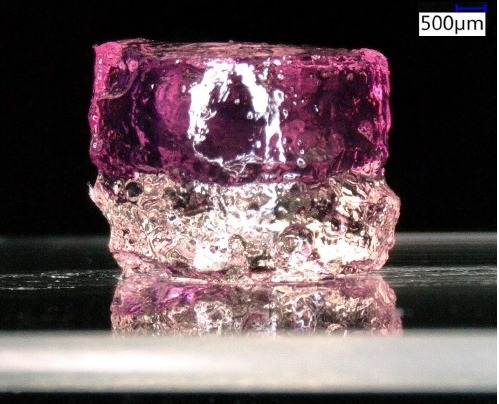
Figure 2. Concept of our stacked hydrogels cast on a standard microscope slide. Photo-polymerizable gelatin methacryloyl (GelMA) (transparent) on glass topped by a red-colored thermoset gelatin layer (red). The image was taken with a digital microscope (Keyence VHX-7000). The scale bar indicates 500